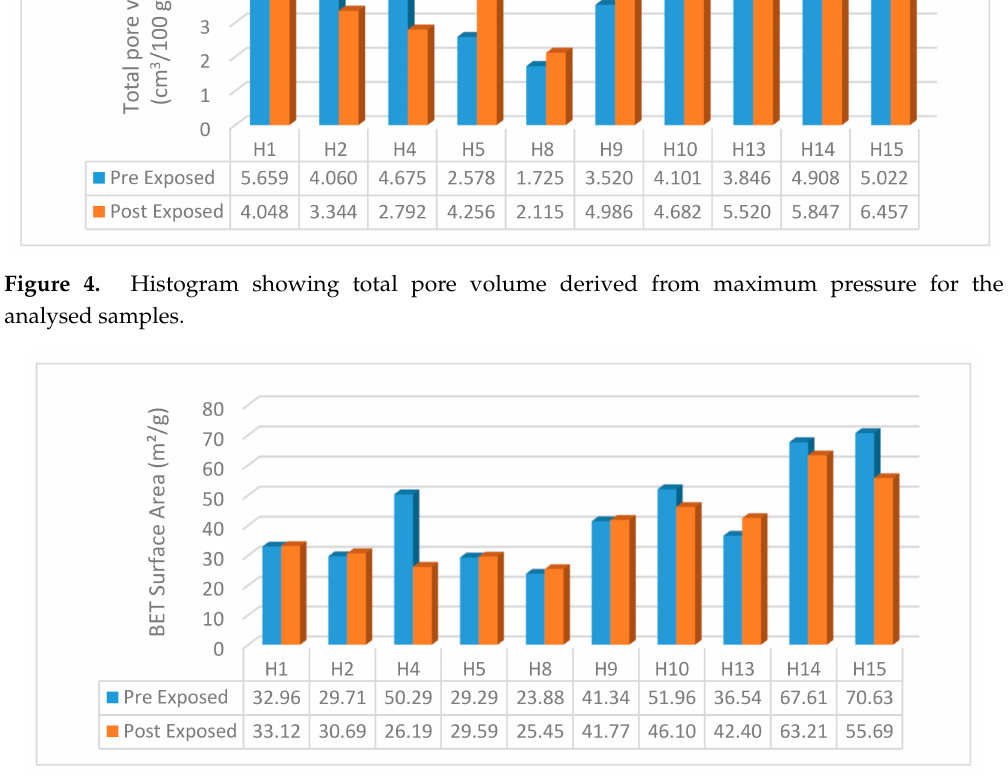
Figure 5. Histogram showing the measured BET surface area for the analysed samples.